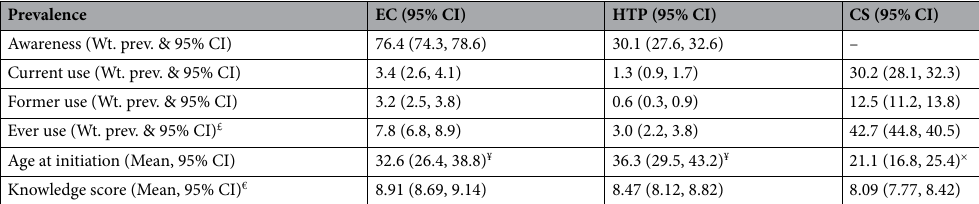
Table 2. Tobacco product use behaviors and knowledge about health effects of CS among adults in Romania GATS 2018. £ Ever CS was those who has ever smoked during lifetime i.e., current, and former CS. × Age at which initiated daily smoking. ¥ Age at which tried EC or HTP even once. € Estimated for only current CS and aware of EC and